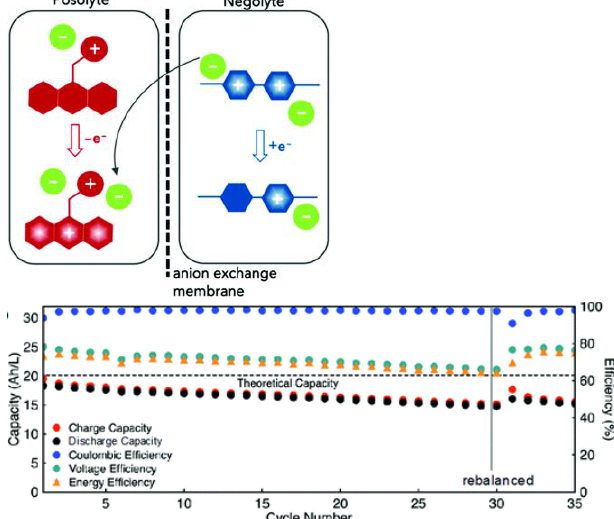
Figure 9. ( Top ) Mode of charge compensation in the supporting − electrolyte − free AORFB of Attanayake et al. The TFSI − anions on a viologen anolyte and on a tetraalkylamonium-modified phenothiazine catholyte are capable of single − handedly balancing charge. ( Bottom ) Monitoring of the capacity of charge/discharge cycles and the Coulombic efficiency over 30 cycles (10 mA cm −2 ). Due to the high cross-over in lieu of a suitable membrane, both electrolyte compartments were “remixed” after cycle 30 to reset the system. Reproduced with permission from Attanayake et al. [147], copyright Royal Society of Chemistry.